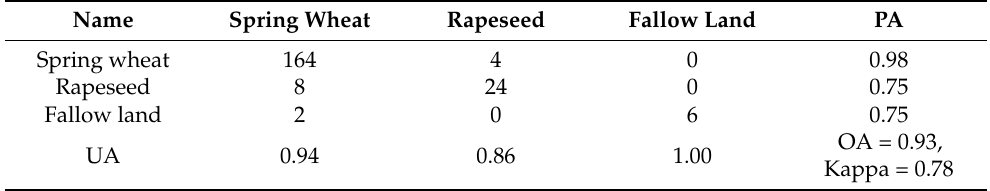
Table 1. Accuracy assessment using Sentinel-2 data from 31 May to 18 September